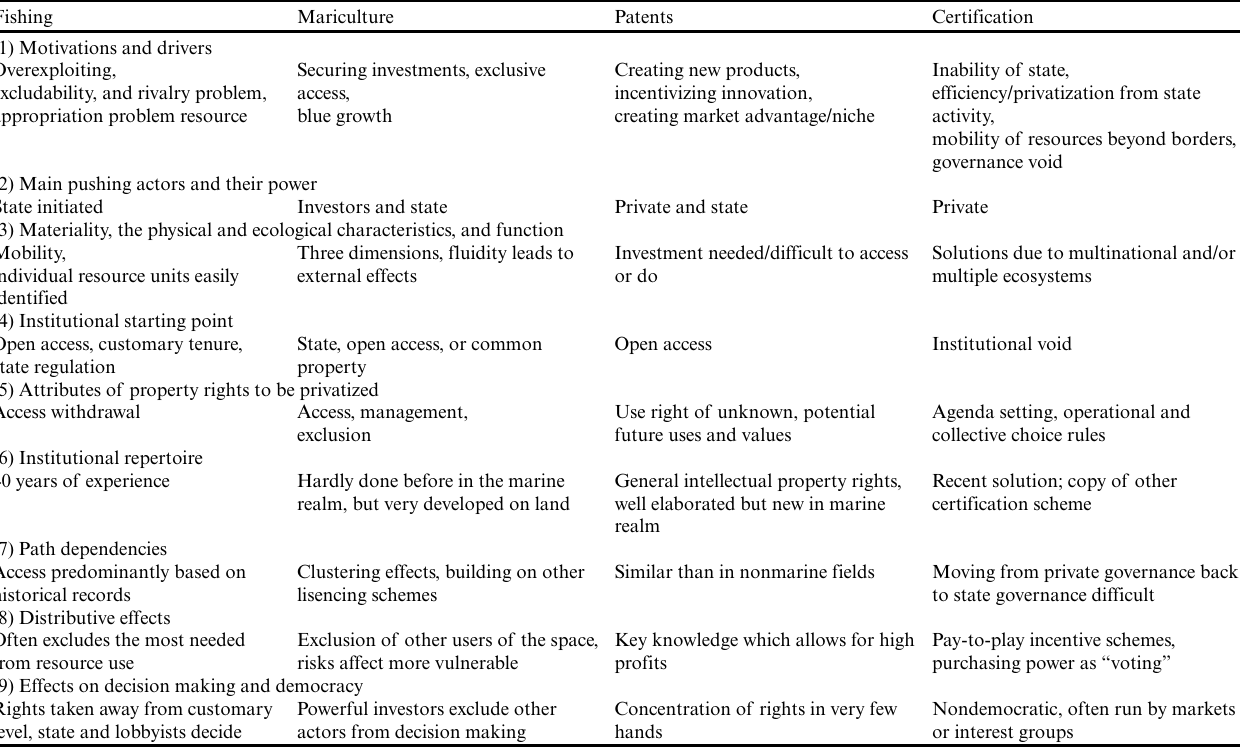
Table 2 . Comparison of ocean privatizations according to the nine criteria.